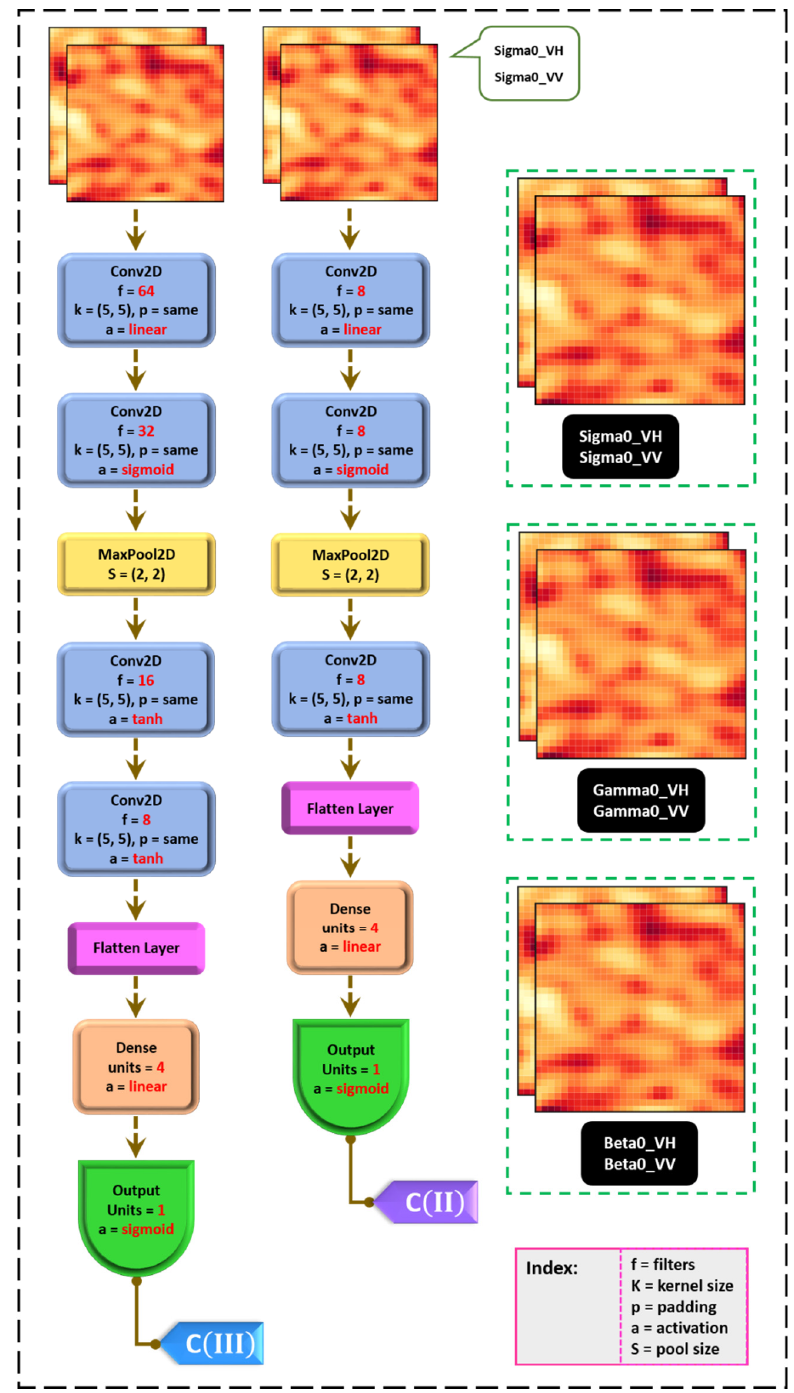
Figure 5. Design (C ( II ) ) and design (C ( III ) ) of convolutional neural